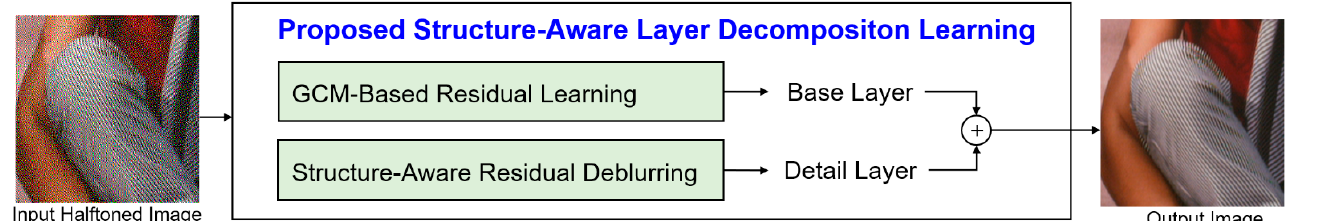
Figure 1. Concept of image decomposition based on proposed SALDL for inverse halftoning.